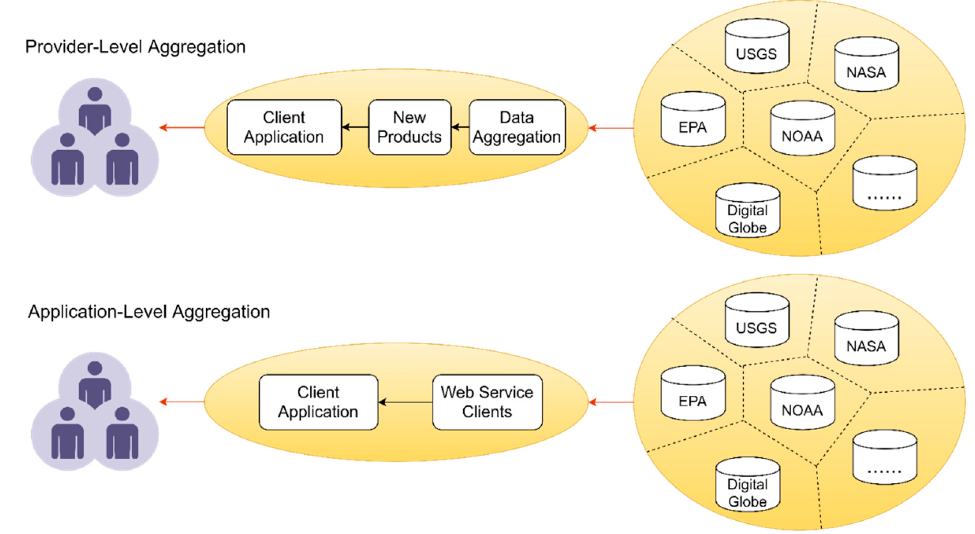
Figure 2. Provider-level and application-level data aggregation.